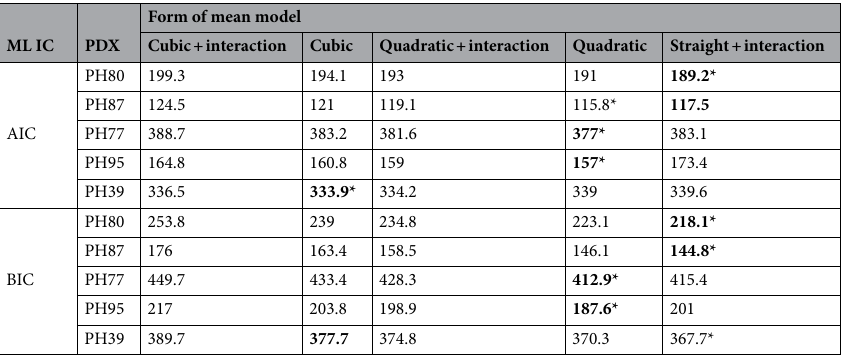
Table 1. ML information criteria for choosing mean model. Lower values are better for both AIC and BIC, and the lowest per PDX model is indicated by *. AIC favors more complex models, while BIC includes a penalty for the number of parameters estimated so tends to favor more simple models with fewer parameters. Bold font indicates the chosen mean model. ML Maximum likelihood, AIC Akaike information criterion, BIC Bayesian information criterion, PDX Patient derived